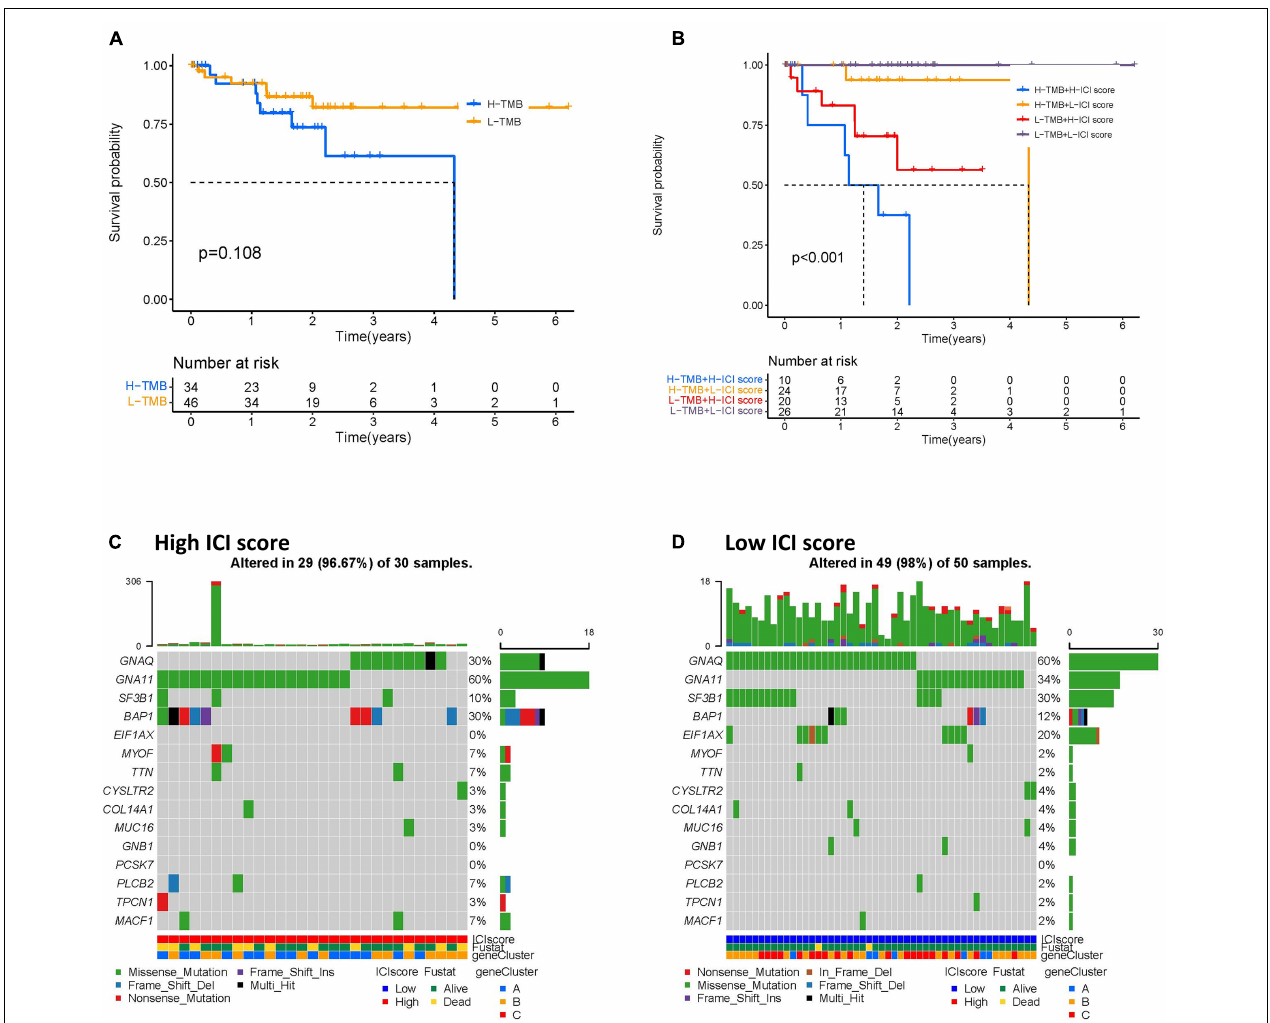
FIGURE 7 | The correlation between the ICI scores and TMB. (A) Kaplan–Meier curves for the high- and low-TMB of UVM patients. Log-rank test shows overall p = 0.108. (B) Kaplan–Meier curves for UVM patients in TMB and ICI score subgroups. Log-rank test shows overall p < 0.001. (C,D) The oncoPrint was constructed by the high- (C) and low-ICI scores (D) of UVM patients. Individual patients are represented in each column. UVM, uveal melanoma; ICI, immune cell infiltration; TMB, tumor mutational